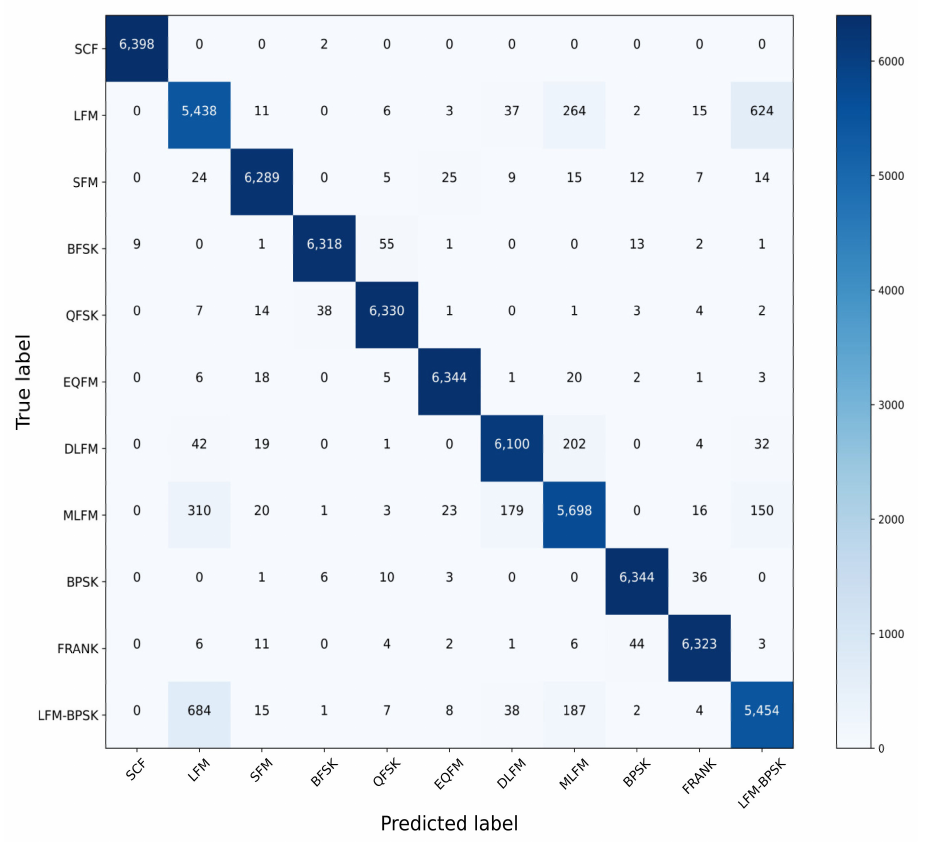
Figure 6. The confusion matrix of the classification result based on 1-D